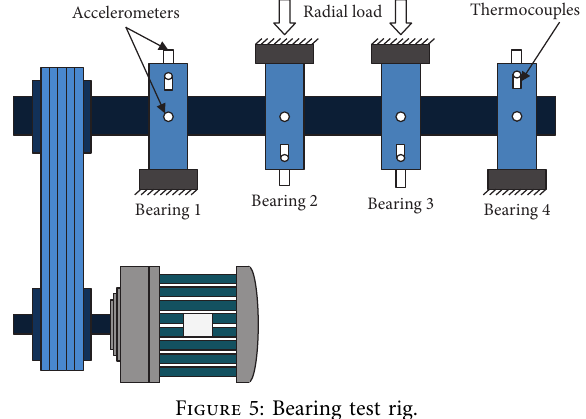
Figure 5: Bearing test